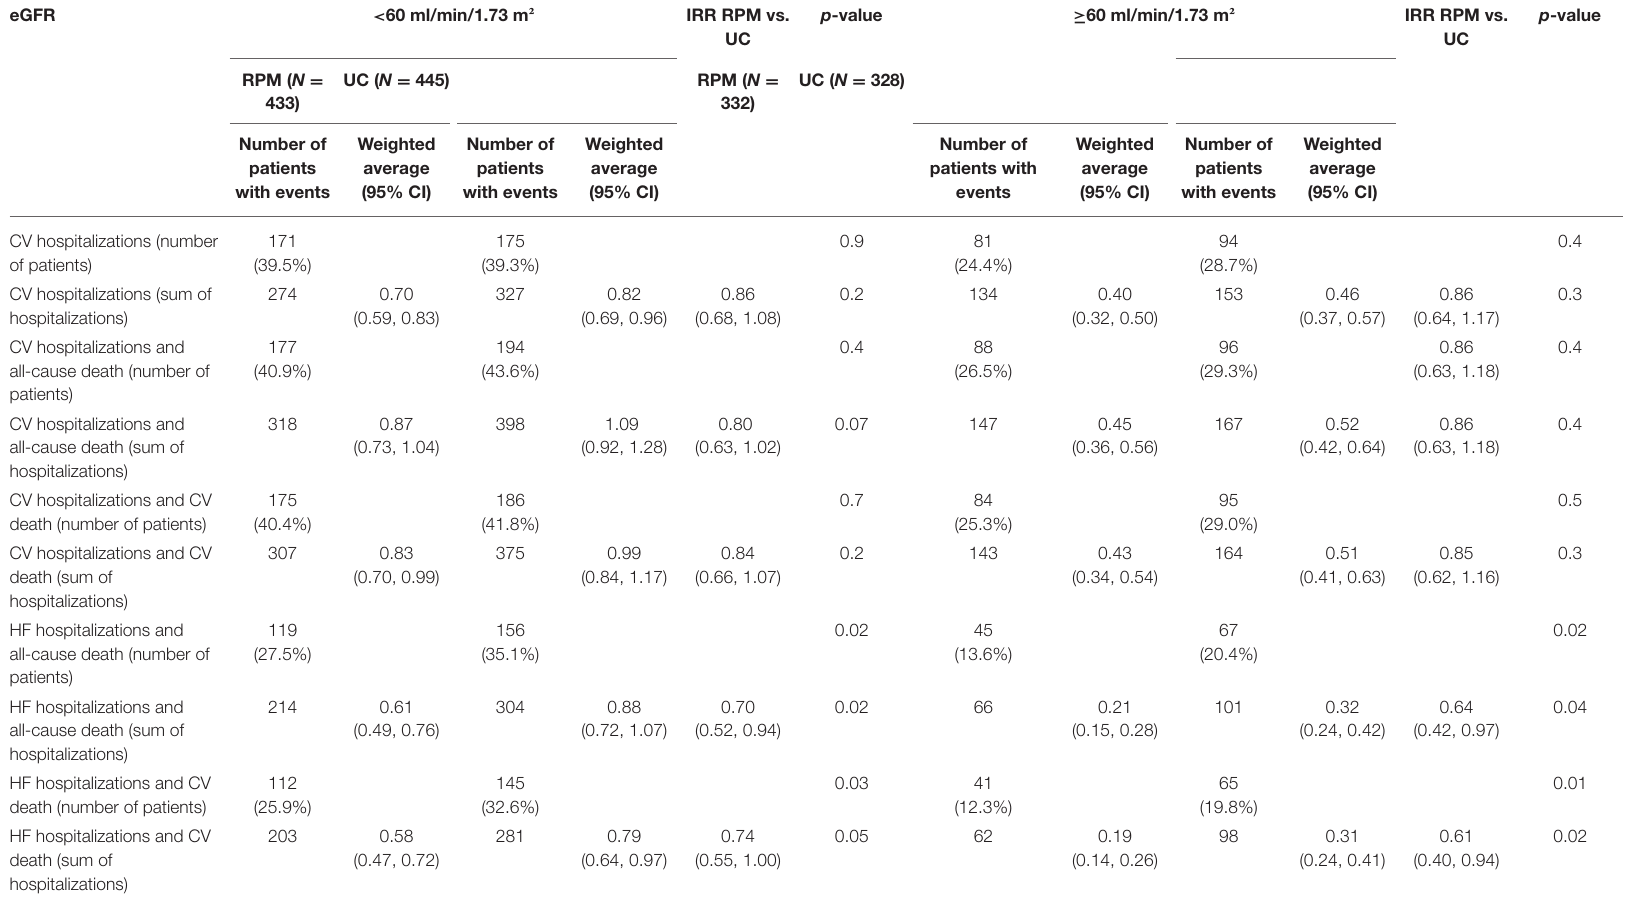
TABLE 5A | Hospitalization as recurrent event analysis of the cohort according to the treatment arm.